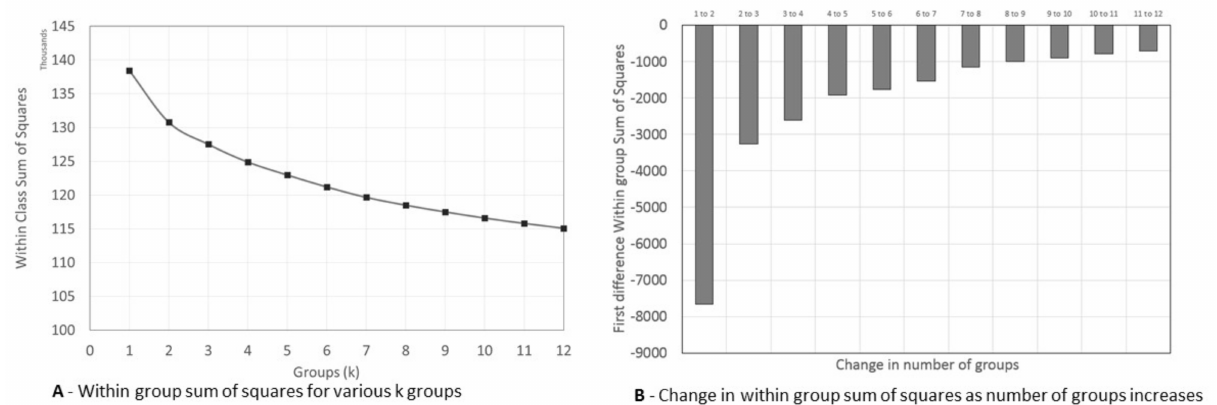
Figure 2. ( A ) Scree plot and ( B ) change in within group sum of square for identifying number of dietary